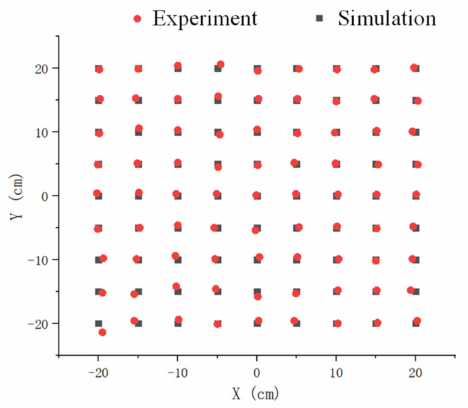
Figure 22. Visual positioning error of a modular